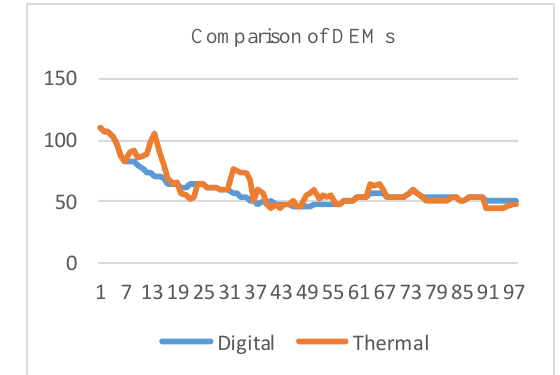
Figure 5. Gray-scale thermal and digital orthophotos